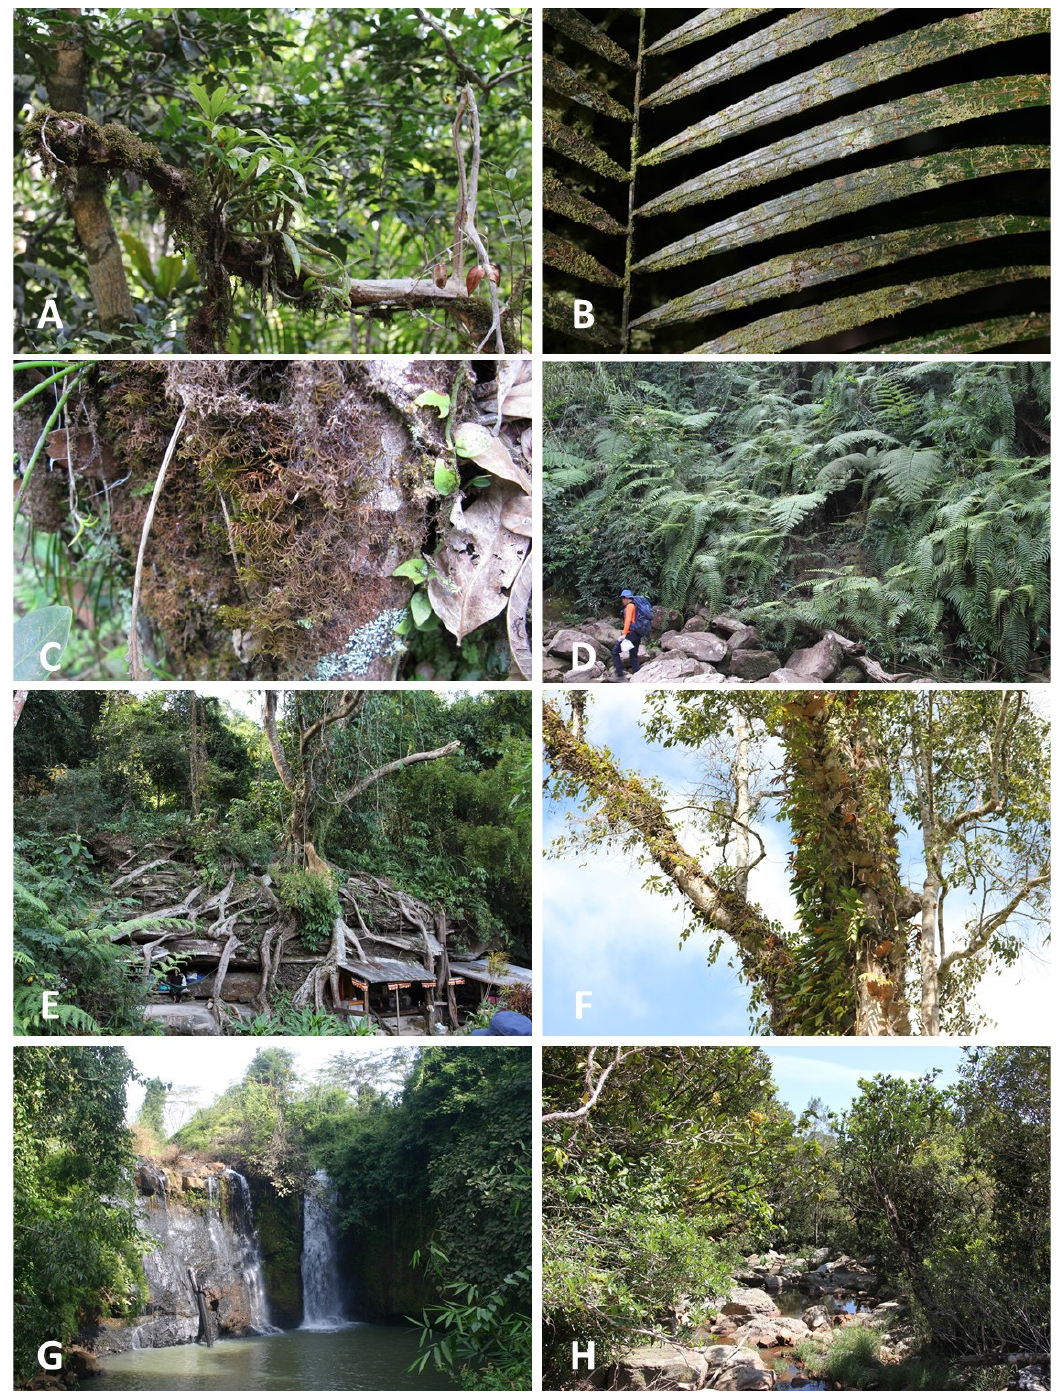
Figure 3. Some habitats of liverworts in Cambodia. ( A ) Hanging on orchids and branches at Bokor National Park in Kampot Province; ( B ) On leaves at Mt. Samkos in Pursat Province; ( C ) On tree bark at Bokor National Park in Kampot Province; ( D ) On fern leaves at Bokor National Park in Kampot Province; ( E ) On tree roots at Bokor National Park in Kampot Province; ( F ) On tree bark at Phnum Krachau Pramaoy District Pursat Province; ( G ) Kachanh waterfall at Banlung District in Rattanakiri Province; ( H ) On rocks near the valley at Bokor National Park in Kampot Province (Photo by S.S. Choi, 2009–2013).